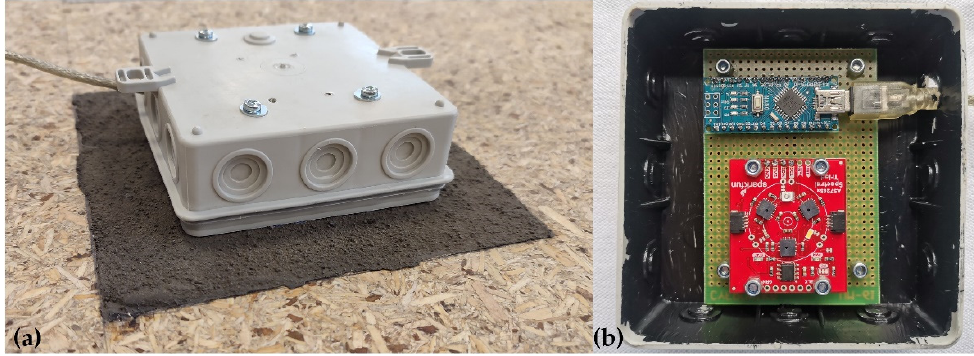
Figure 9. Spectrometer measurement of an LSS specimen ( a ) general view ( b ) interior of the de ‐ vice.